Question: Summarize what this figure shows in one sentence.
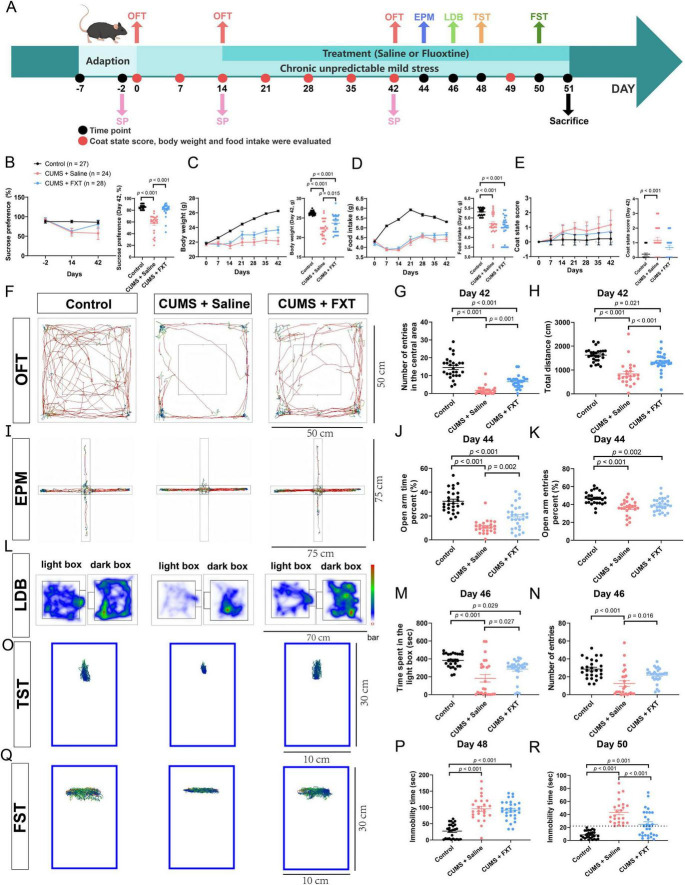
Answer: Timeline and validation of the experimental design for the CUMS Model. (A) Establishment of the CUMS mouse model, administration of the positive control drug fluoxetine, and behavioral testing period. (B) As depicted in the left Figure, exposure to the CUMS paradigm resulted in a substantial manifestation of anhedonia, as evidenced by the SP test. Additionally, on the 42nd day of the experiment, discernible differences in the percentage of water preference were observed among the various groups, as displayed in the right Figure. (C – E) In the left Figure, the CUMS paradigm was found to induce significant alterations in coat state score, body weight, and food intake. Furthermore, on the 42nd day of the experiment, the right Figure depicts a comparison of variations among the three groups. (F) On the 42nd day, OFT trajectories were recorded and analyzed. (G) On the 42nd day, mice in the CUMS + FXT group exhibited a higher number of center entries during the OFT. (H) CUMS + FXT mice exhibited reduced anxiety- and depression-like behaviors, as indicated by significantly greater distances traveled during the OFT (I,J) . During the EPM test, CUMS + Saline group spent less time exploring the open arm, with a notable difference observed between the CUMS + Saline and CUMS + FXT groups. (K) No significant difference in behavior was observed between the CUMS + Saline and CUMS + FXT groups. (L,M) CUMS + Saline group exhibited significantly reduced exploration time in the light box during the LDB test. (N) On the 46th day, the control group had a significantly greater entry during the LDB test. (O–R) During the TST and FST, mice in the CUMS + Saline group exhibited significantly more extended periods of immobility. The presented data represent mean ± S.E.M. Statistical significance was established when p -values were below 0.05. The number of animals is indicated on the graphs. A repeated measures ANOVA was employed to assess potential disparities among groups. In cases where i